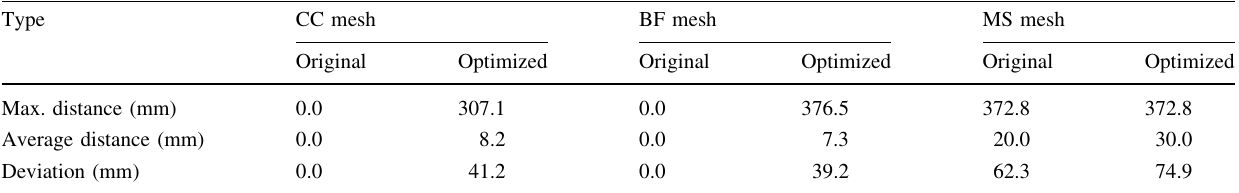
Table 3 Comparison of original point cloud to the Coc Sau meshes